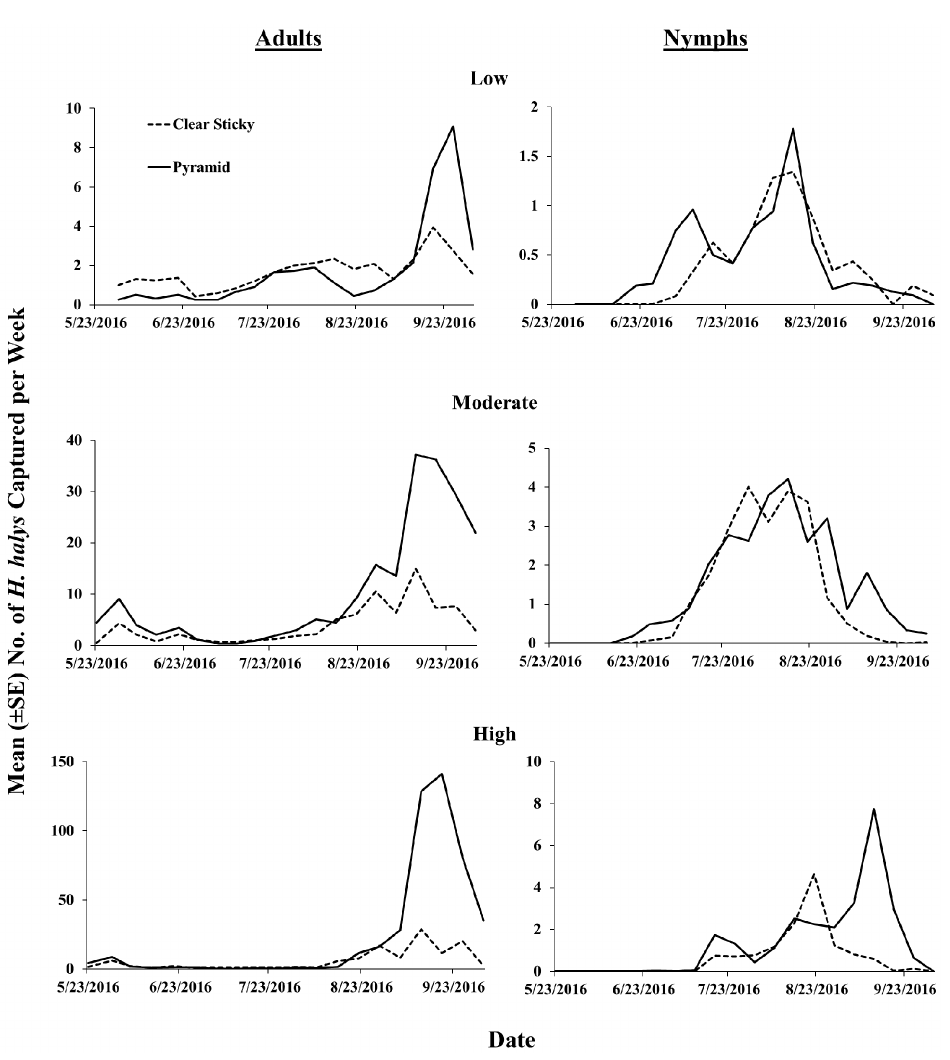
Figure 4. Seasonal trends in the captures of H. halys nymphs and adults using clear sticky traps and pyramid traps at low, moderate and high relative population density sites in 2016. Data pooled across all lure types and rates.